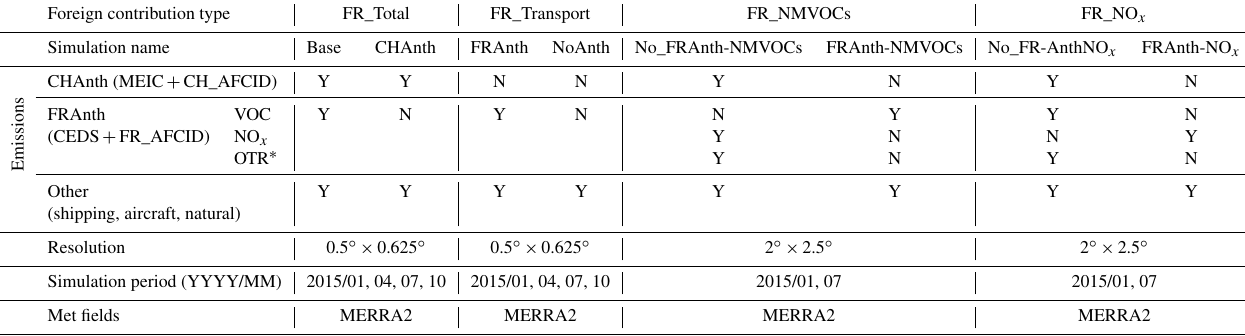
Table 1. Configuration summary of GEOS-Chem simulations in this study. Emission abbreviations are elaborated in Sect.